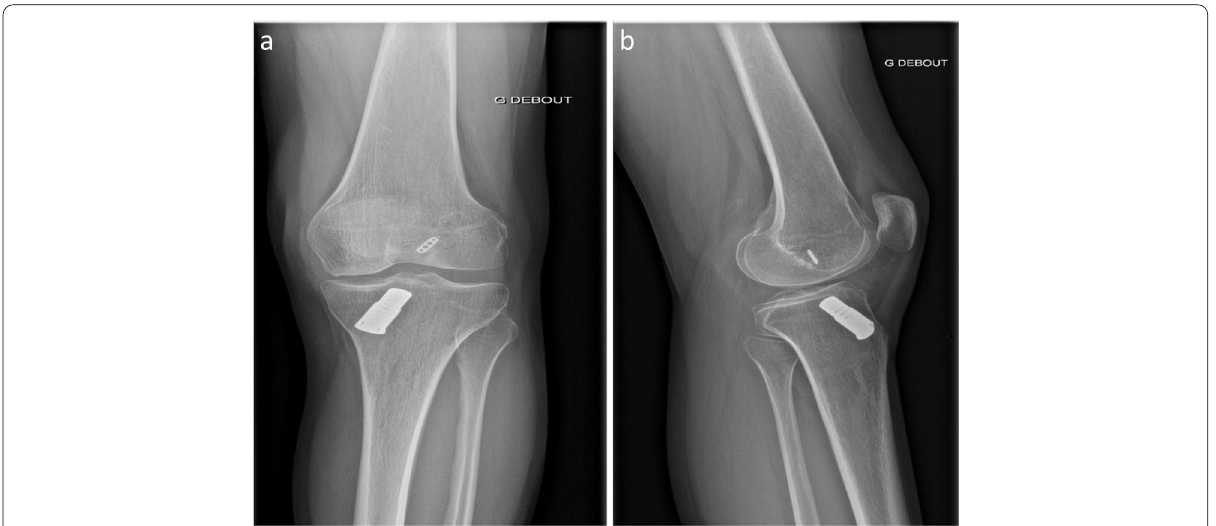
Fig. 3 Preoperative anteroposterior (a) and lateral (b) X-rays before implant removal showing significant malposition of the femoral tunnel and improper position of the endobutton which had not flipped over the femoral cortex